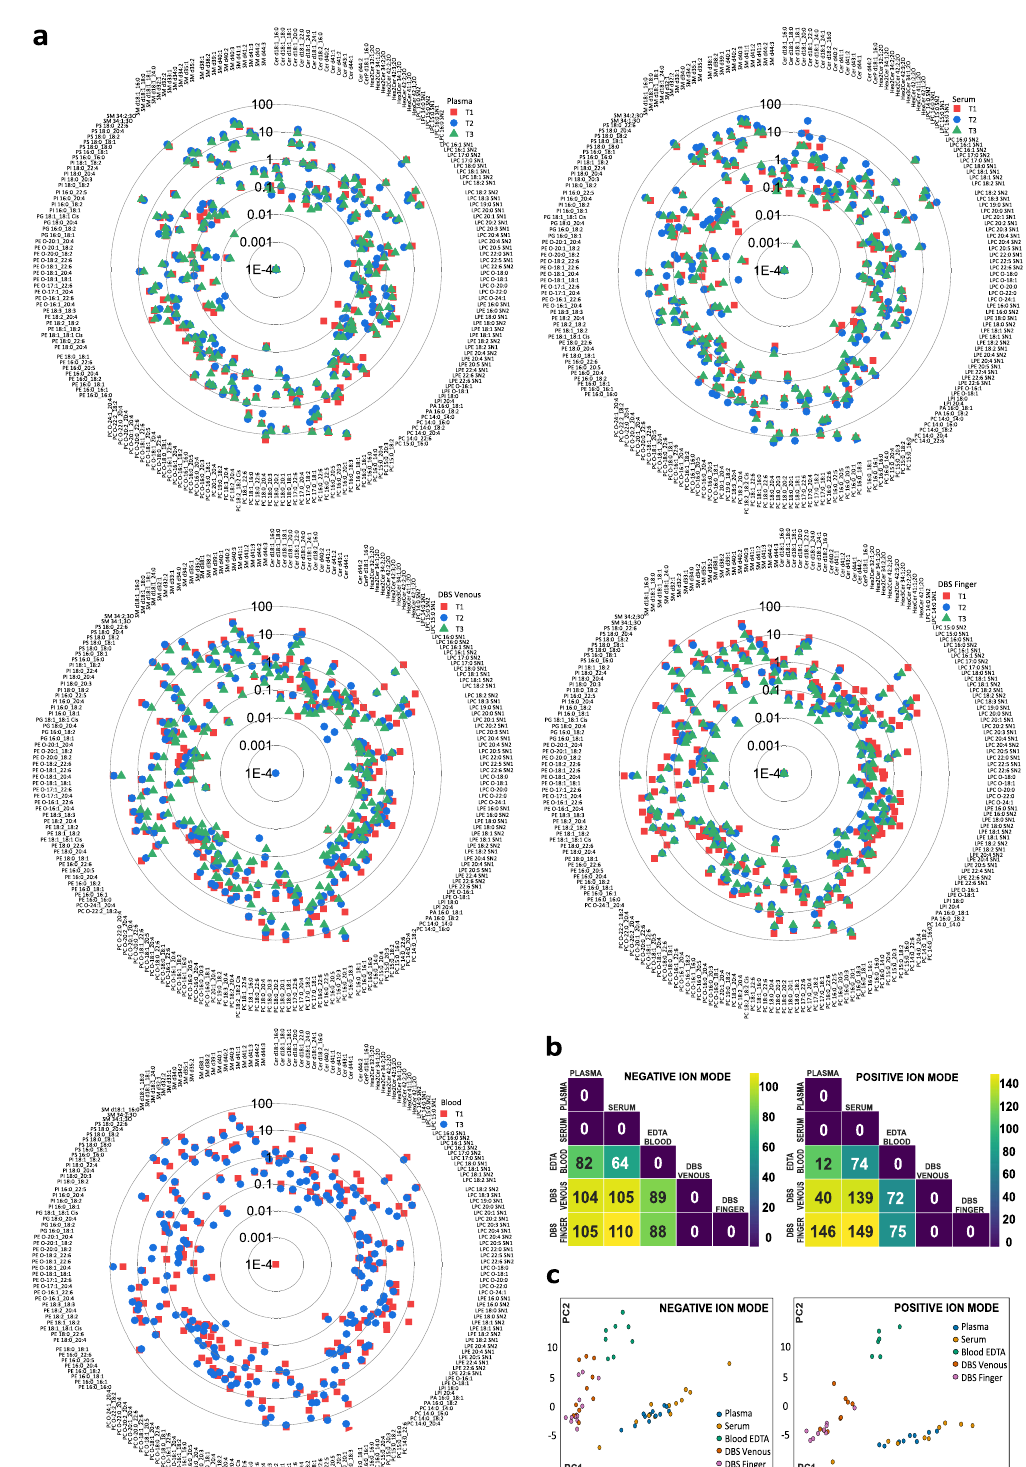
Fig. 7 | Radar plot and statistical output for the quanti fi ed results from the negative mode in the LBlooD study. a The radar plots represent the log 10 con- centration of the quanti fi ed lipid species in all fi ve biological matrices for an indi- vidual over the three-time points. b The two-sided Wilcoxon signed-rank test output shows the similarities and dissimilarities between different biological matricesforanindividualinnegativeionmode(left)andpositiveionmode(right).